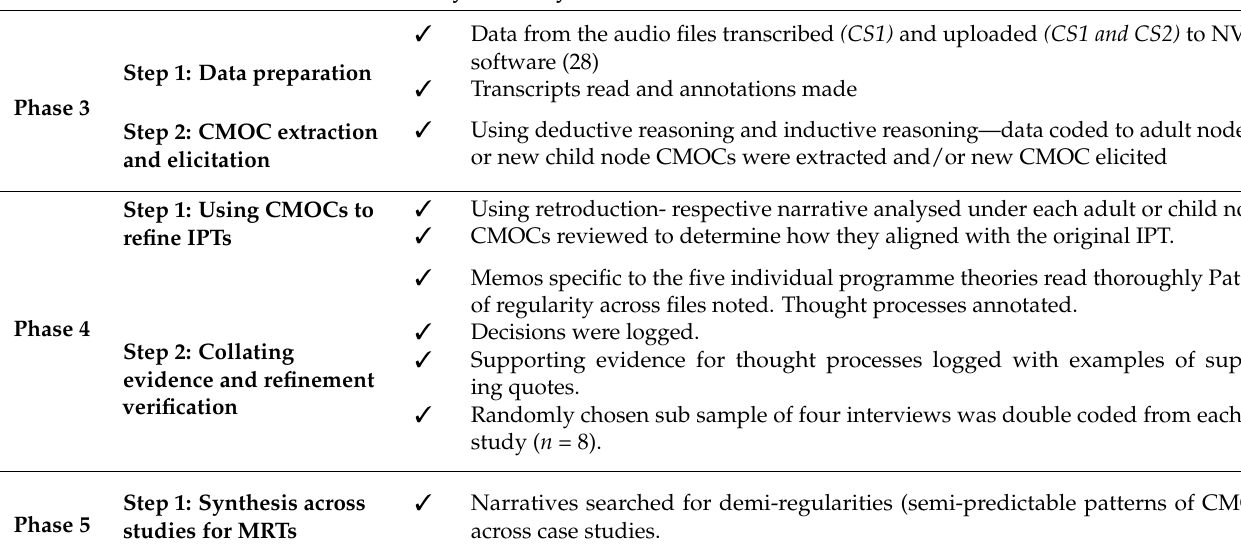
Table 3. Data analysis phases. Data Analysis and Synthesis within Realist Evaluation